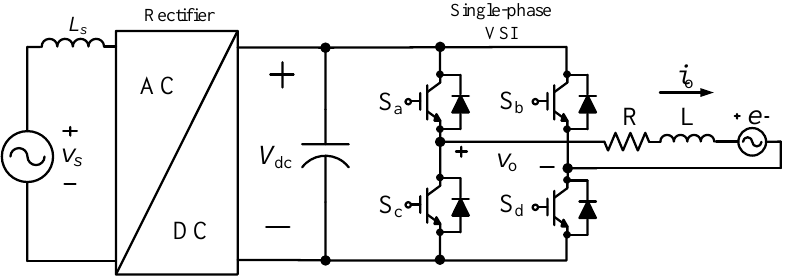
Figure 1. Single-phase voltage source inverter (VSI) with an AC/DC rectifier.